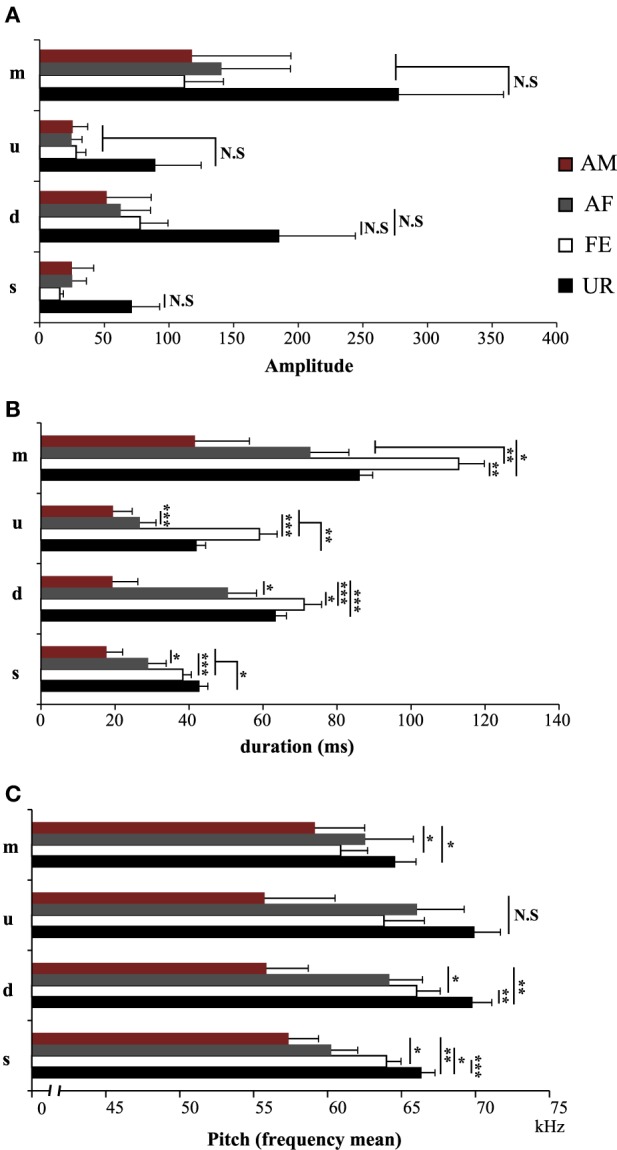
Characteristics of individual syllables in different contexts. (A) Amplitude of individual syllable types. NS, Non significant. (B) Duration of individual syllable types. (C) Pitch (frequency mean) of individual syllable types. Data are presented as mean ± SEM (n = 12 males). *p < 0.05, **p < 0.005, ***p < 0.0001 for post-hoc Student's paired t-test after Benjamini and Hochberg correction. NS, Non significant.